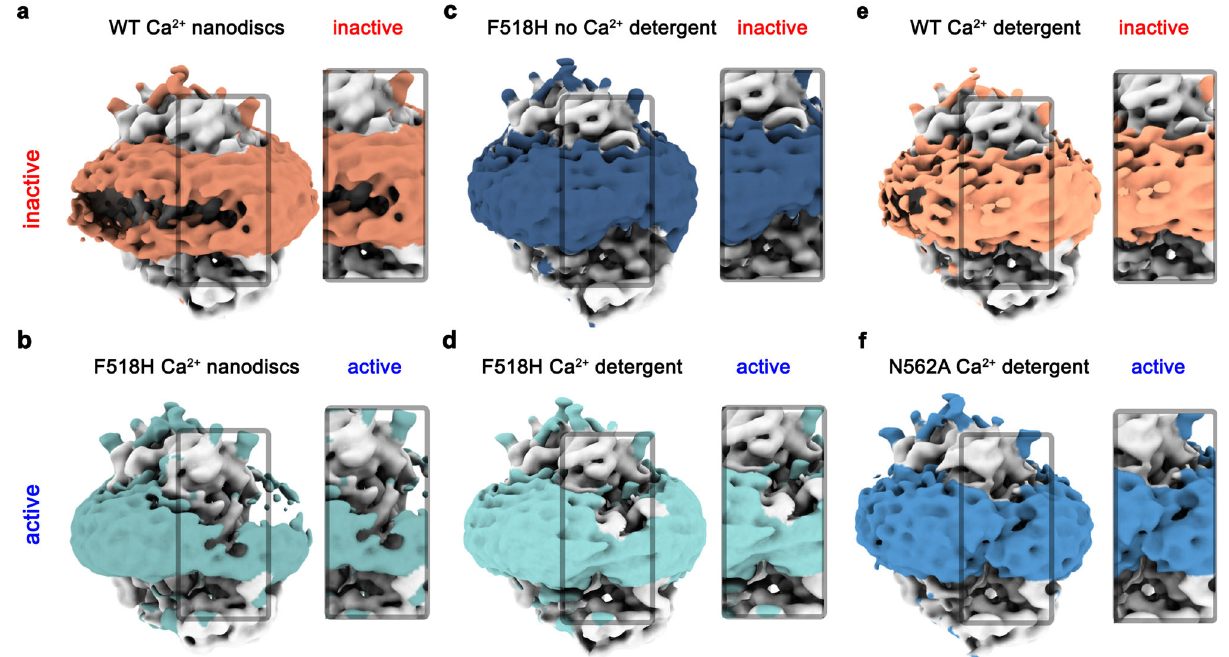
Fig. 7 | Structural properties of the detergent and lipid region in inactive and active states. Densities of a Ca 2+ -bound TMEM16F WT in 2N2 lipid nanodiscs (PDBID 6QPC, WT Ca ND ), b the Ca 2+ -bound TMEM16F F518H mutant in 2N2 lipid nanodiscs (F518H Ca ND ), c the Ca 2+ -free TMEM16F F518H mutant in digitonin (F518H noCa ), d theCa 2+ -boundTMEM16FF518Hmutantindigitonin(F518H Ca ), e Ca 2+ - bound TMEM16F WT in digitonin (PDBID 6QP6, WT Ca ), and f the Ca 2+